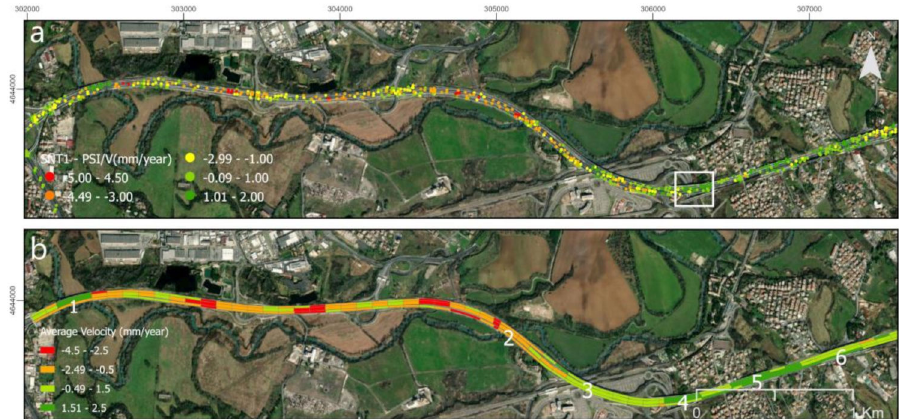
Figure 10. ( a ) Displacement map PSI Sentinel-1 A24 highway, ( b ) Map classification sections average velocity (mm / year) and bridge 1-6, as background ESRI source